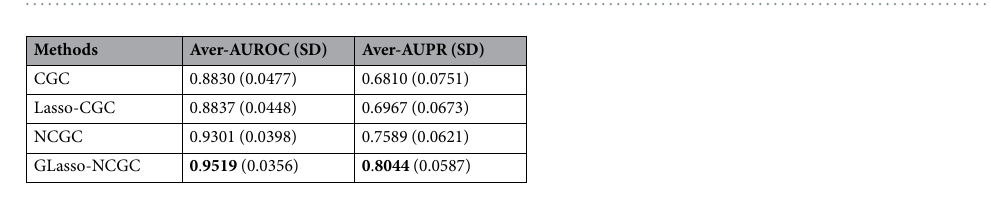
Table 2. Average AUPR and Average AUROC of different methods in nonlinear VAR simulation (standard deviation (SD) in parentheses). The values are obtained by averaging over 100 independent